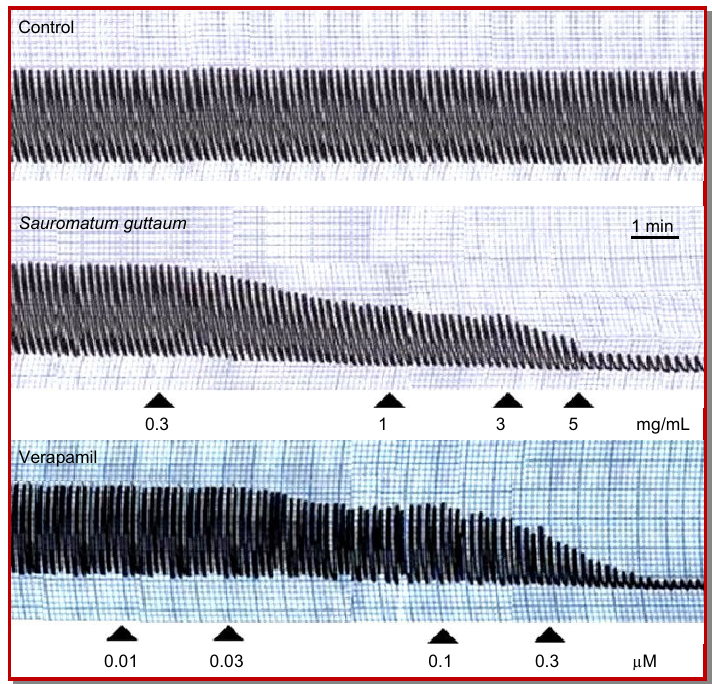
Figure 1: A representative tracing shows the spasmolytic effect of the crude extract of S. guttaum and verapamil on spontaneous contractions in isolated rabbit jejunum